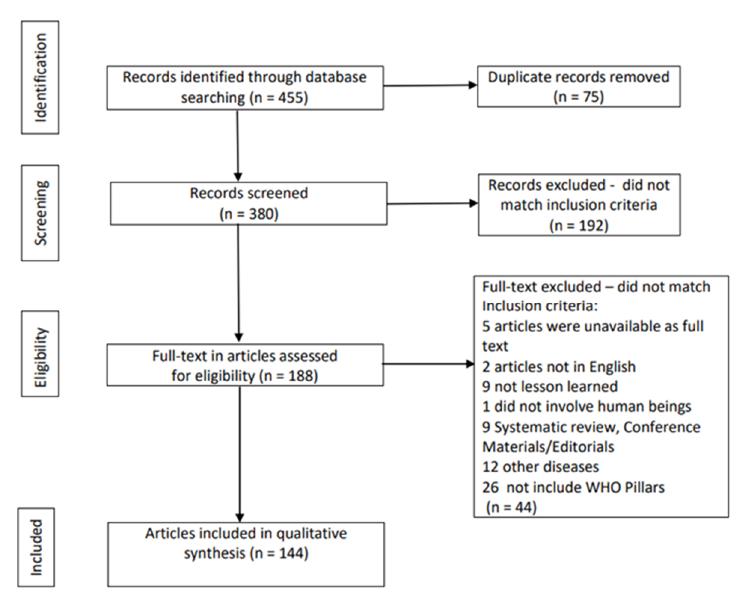
Figure 1. Flow diagram of studies’ selection, conforming to PRISMA guidelines.